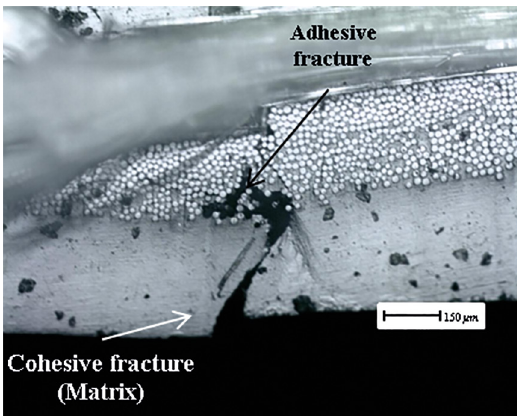
Figure 19. Fracture characteristic – HFCL laminate